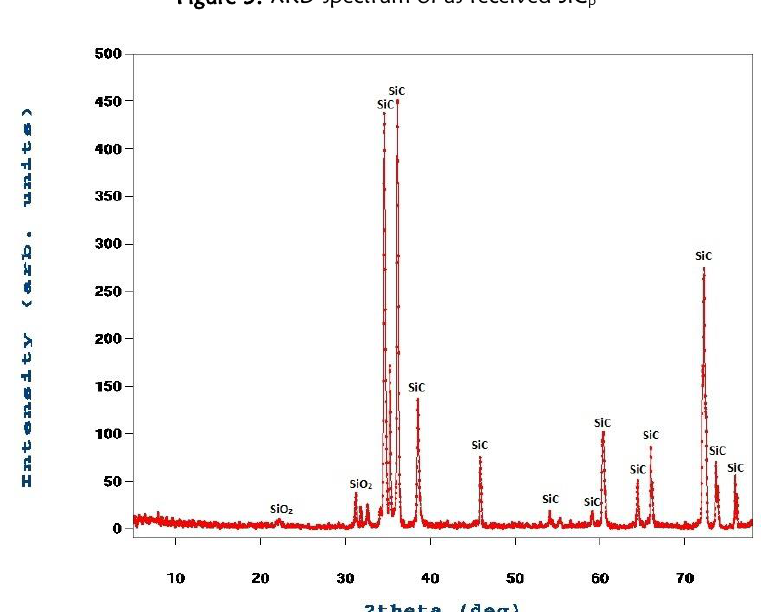
Figure 5: XRD spectrum of as-received SiC p